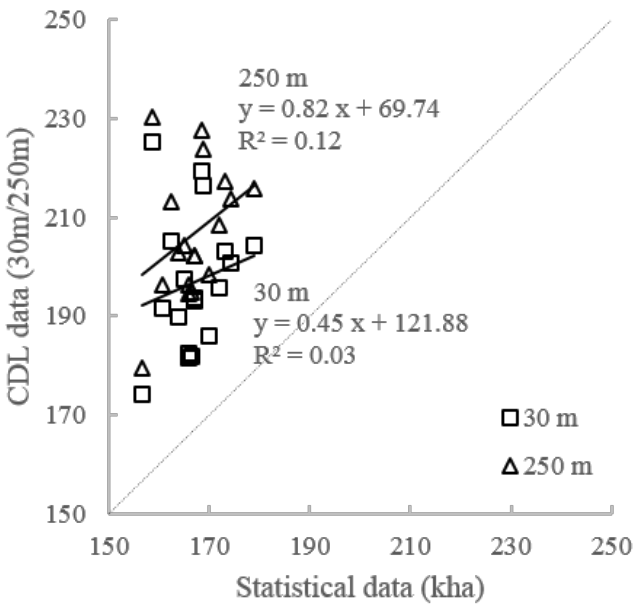
Figure 2. The sugarcane planting area from CDL maps with original 30 m and resampled 250 m spatial resolutions against statistical data from 2008 to 2016.